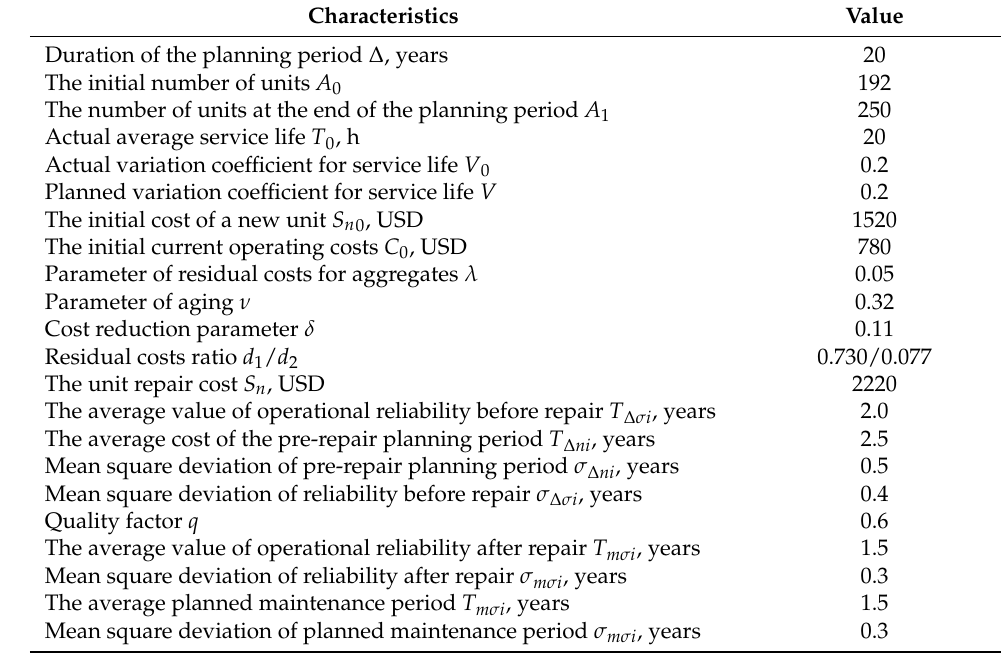
Table 1. Results of the service optimization